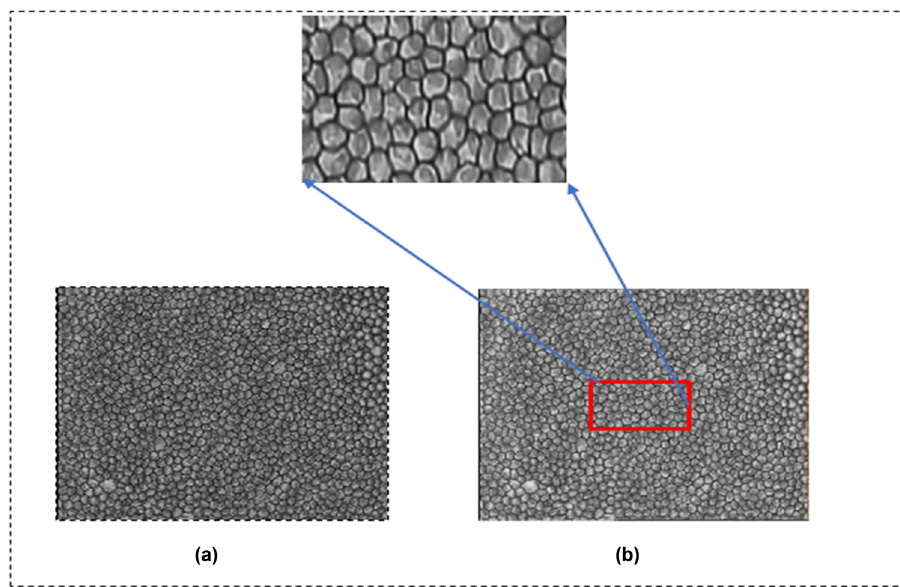
Figure 10: The e ff ects of enhanced such that ( a ) is the resulting image from CLAHE and ( b ) is the result of enhanced WT.